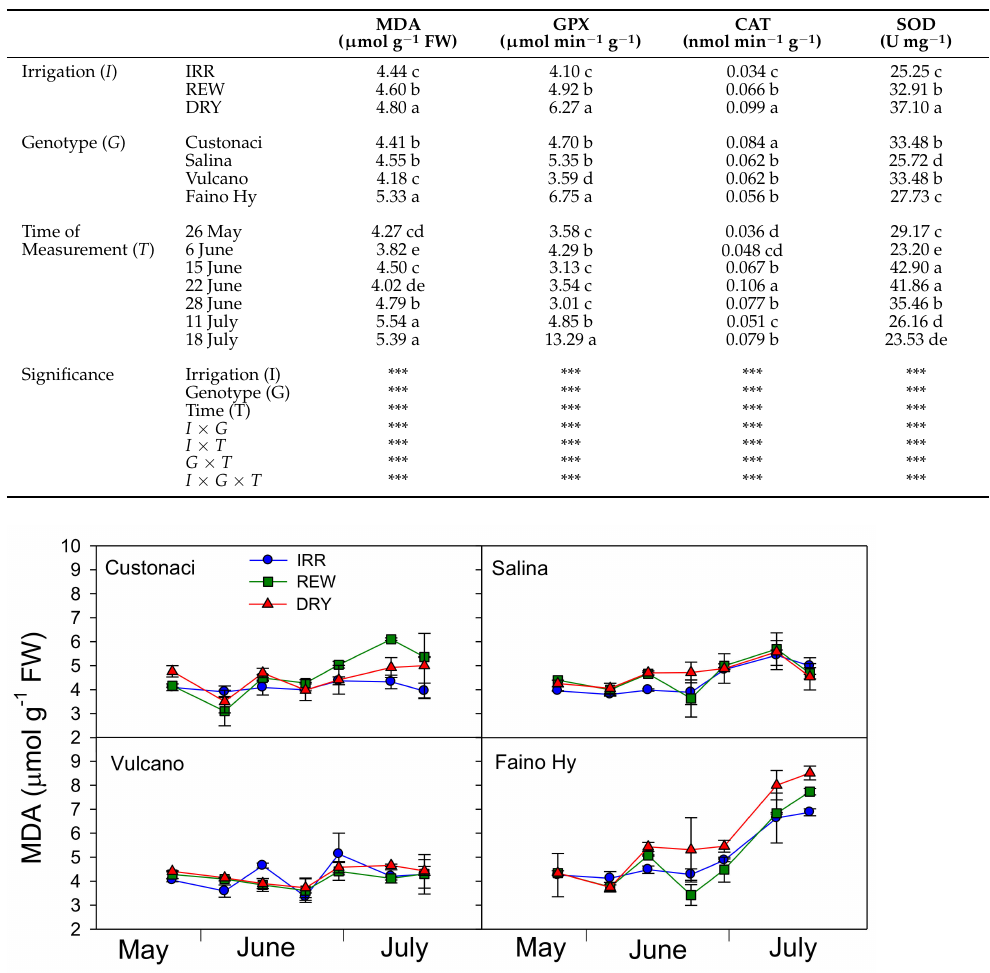
Table 2. Mean effects of irrigation ( I ) (IRR: full irrigation; REW: rewatering; DRY: no irrigation), genotype ( G ), and time of measurement ( T ) on MDA, GPX, CAT, and SOD, in tomato (on a fresh weight basis). Values within each column, followed by the same letter, do not significantly differ at p ≤ 0.05 (Tukey’s test). ANOVA significance results are also reported: significant at p ≤ 0.001 (***).